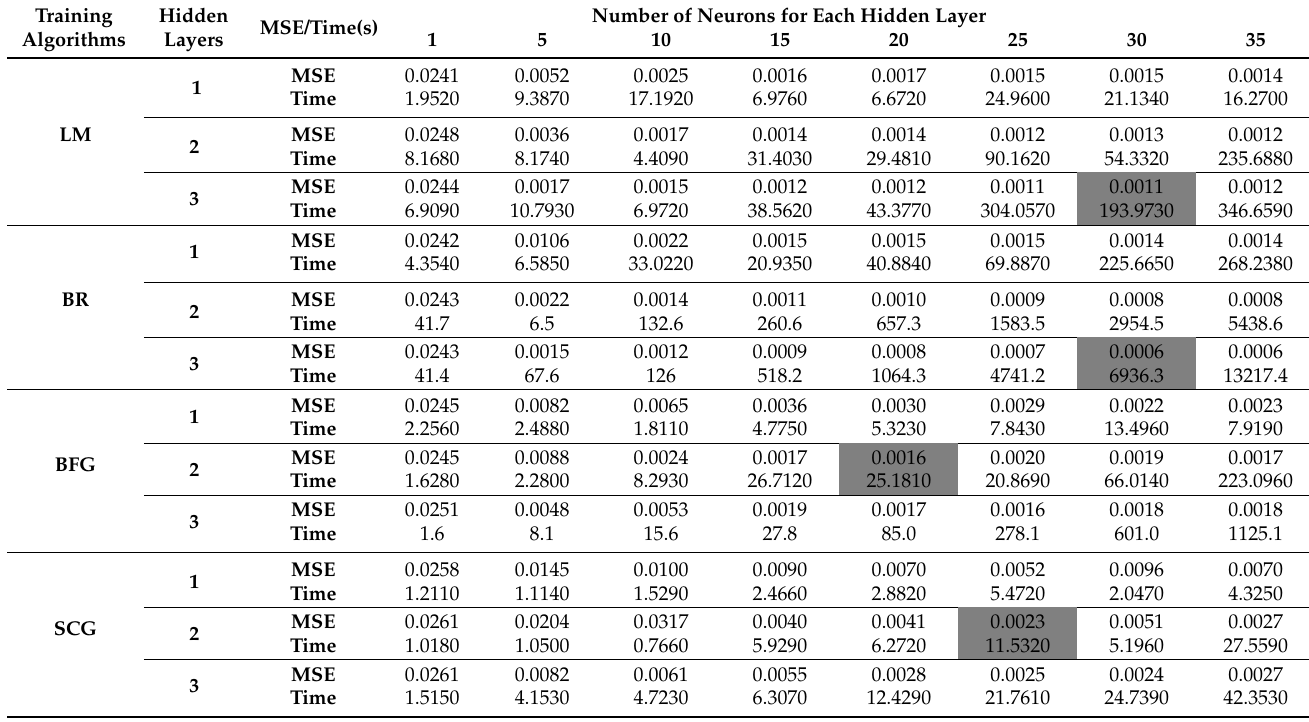
Table 1. Mean squared error of different FFNNP